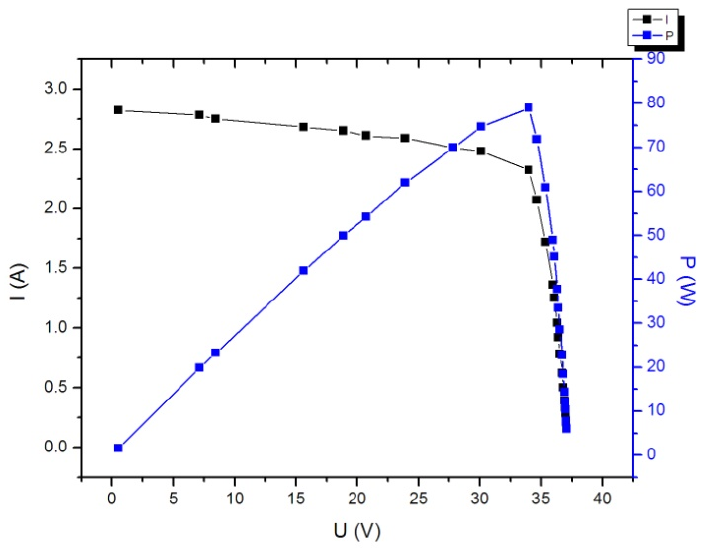
Figure 8. The V - I characteristic curve and the power output curve of PV power generation.